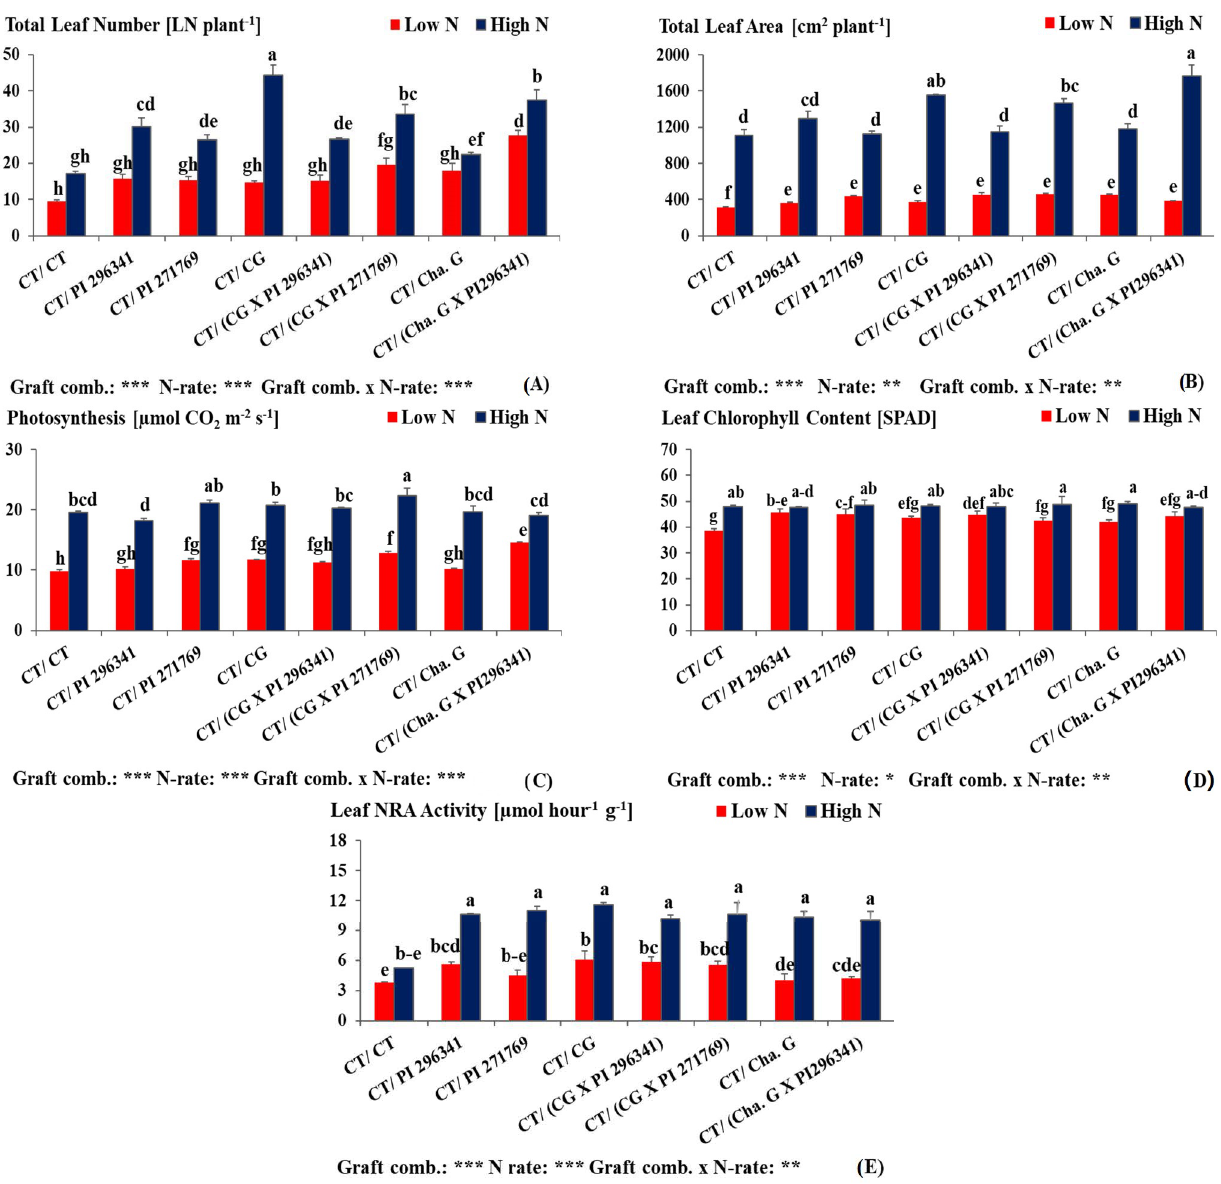
Figure 1. Total leaf number ( A ), total leaf area ( B ), the intensity of photosynthesis measurements ( C ), leaf chlorophyll content ( D ), and leaf NRA activity ( E ) of self-grafted and grafted watermelon cultivars grown under low N dose (0.3 mM) and high (3.0 mM) N dose. CT: Crimson Tide, CG: Calhoun Gray, Che. G: Chearleston Gray, Z Values represented by different letters shows significant differences between graft combination within both columns at P < 0.05. F values: ns, non-significant. * p < 0.05, ** p < 0.01 and *** p < 0.001.